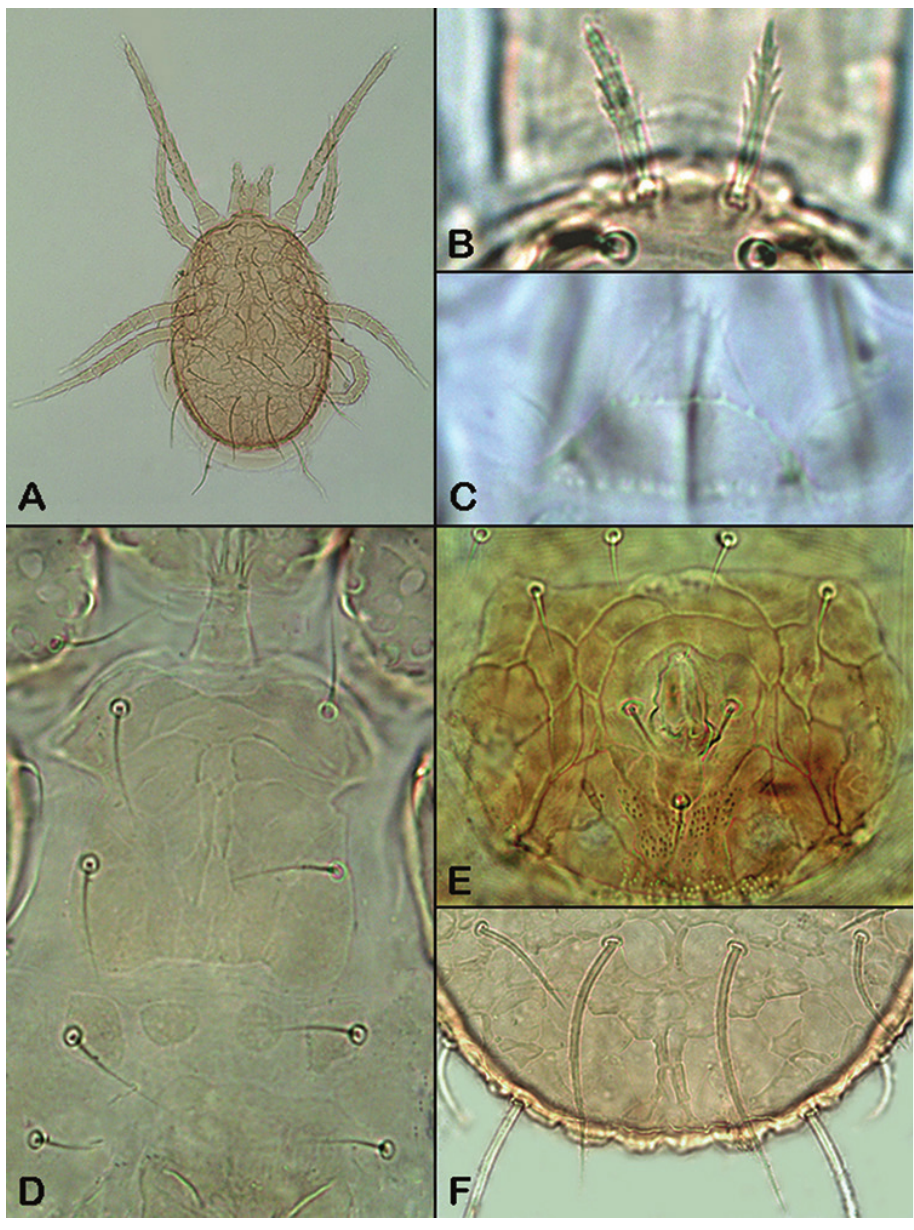
Plate 16. Ameroseius furcatus , female. A Dorsal idiosoma with legs B Setae j1 C Epistome D Sternal shield and metasternal area E Ventrianal shield F Posterior margin of dorsal